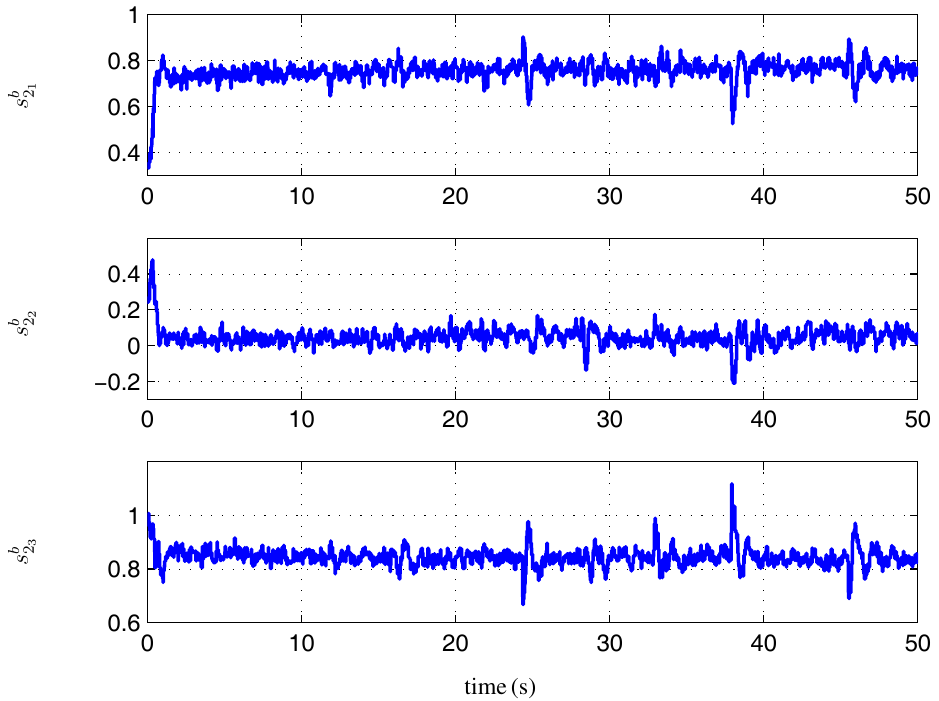
Figure 9. Control law of Corollary 1: the evolution of the magnetometer measurement s b